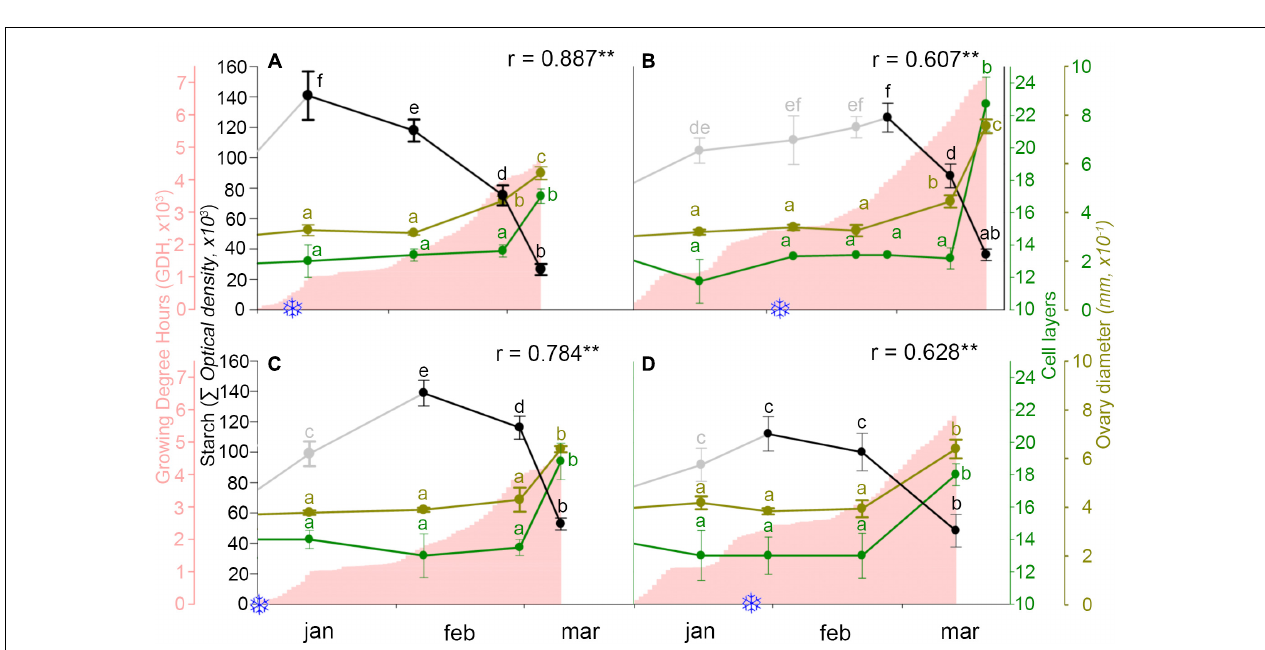
FIGURE 5 | Ovary starch content (solid circles) and chilling unit accumulation (blue line) in two sweet cherry cultivars during 2 years. (A) ‘Bing,’ cold year. (B) ‘Bing,’ mild year. (C) ‘Burlat,’ cold year. (D) ‘Burlat,’ mild year. Snowflakes: dates of chilling fulfillment. r , Pearson’s correlation coefficients between the starch content and the chilling unit accumulation for each cultivar and year. ∗ P < 0.05; ∗∗ P < 0.01 ( n = 6). Different letters (a–f) indicate significant differences ( P < 0.05) using the Duncan’s multiple-range test.